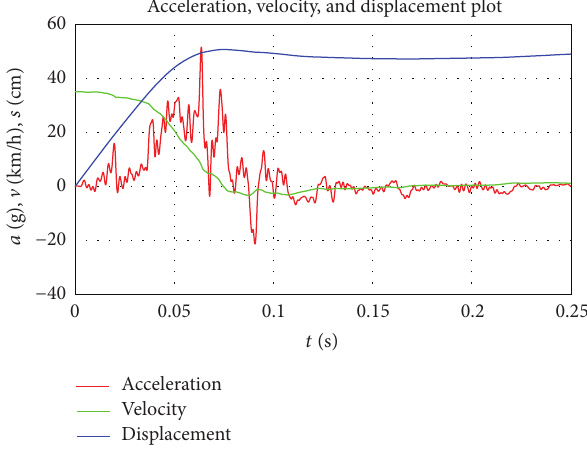
Figure 1: Crash test